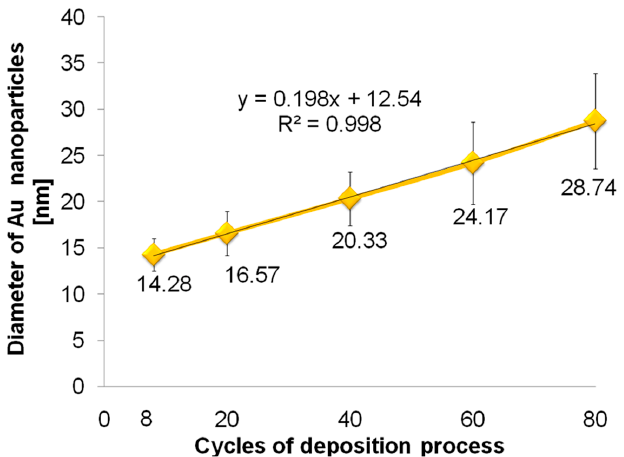
Figure 2. The average values of AuNPs diameter with SD formed and deposited onto TNT susing CV method carried out in 0.1 mM HAuCl 4 for different number of cycles. Table 1. The average values of OCP, diameter of AuNPs and EDS results (n = 3) with SD measured for thermally modified TNT arrays before and after deposition of AuNPs using CV method carried out for